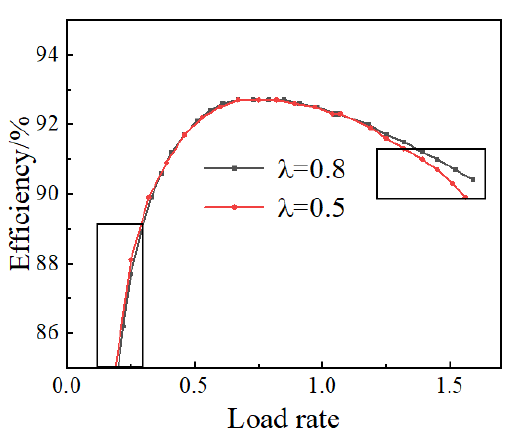
Figure 24. Magnification diagram of efficiency.